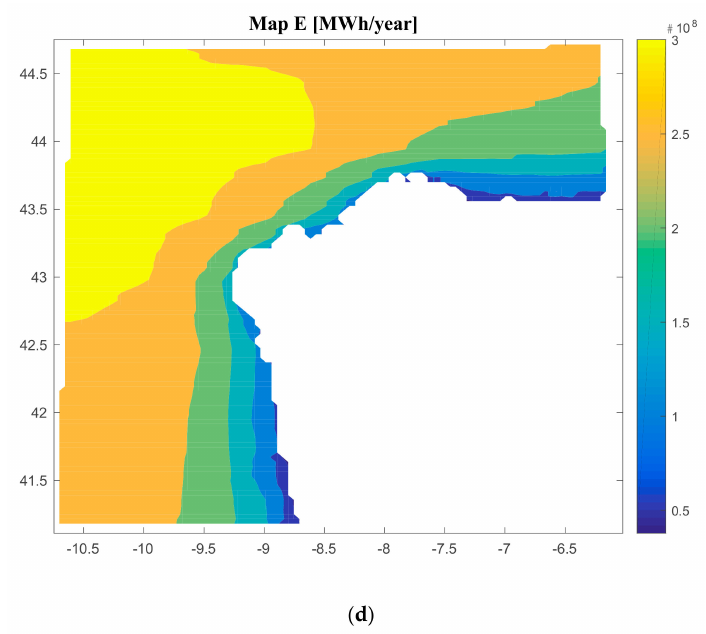
Figure 7. Results of the energy produced for Case 1 ( a ); Results of the energy produced for Case 2 ( b ); Results of the energy produced for Case 3 ( c ); Results of the energy produced for Case 4 ( d